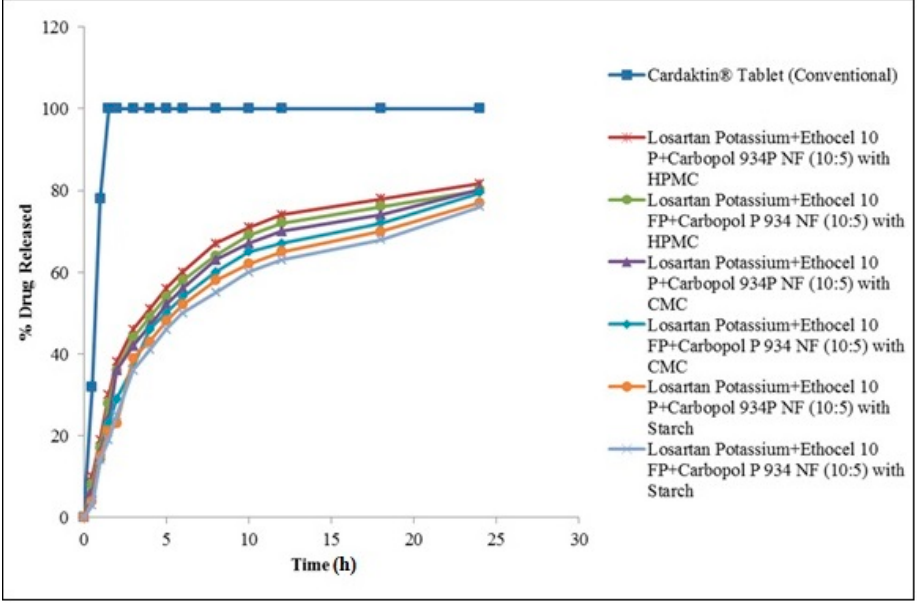
Table 5. Drug release kinetics parameters (n = 3, mean ± SD).